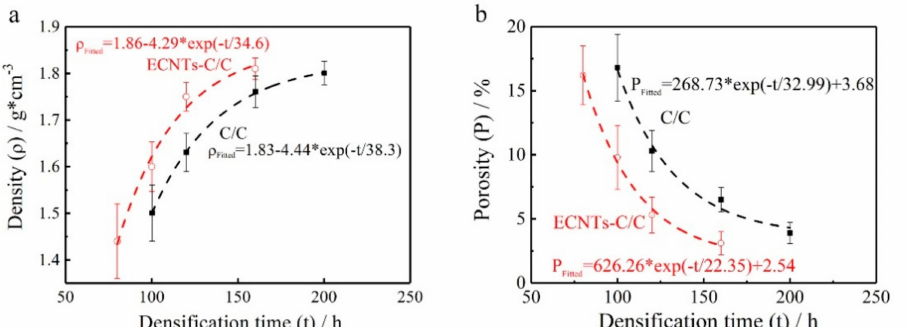
Figure 3. ( a ) Density and fitted limit density of CC/C and traditional C/C composites; ( b ) Porosity and fitted limit porosity of CC/C and traditional C/C